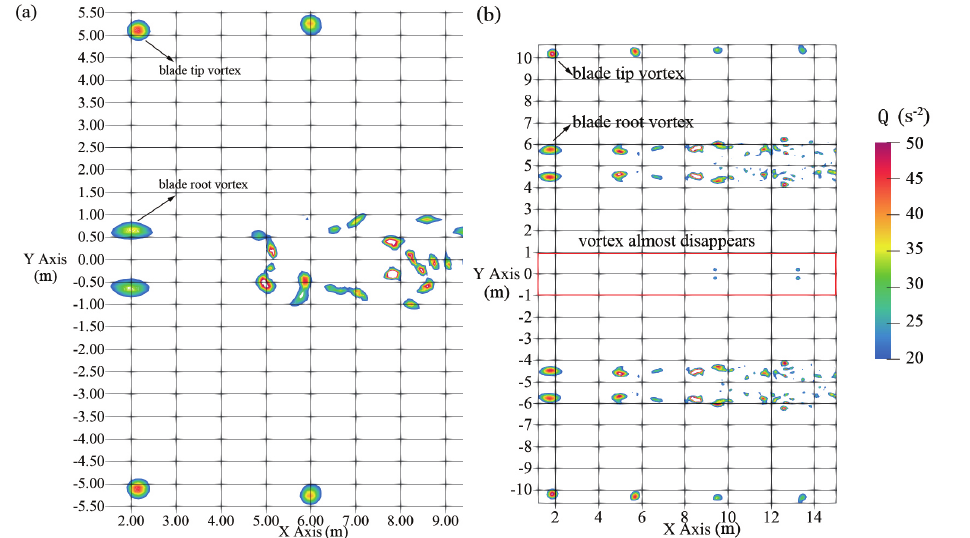
Figure 5. The vortex contour at z = 12.2 m: ( a ) Single-rotor; and ( b ) twin-rotors.